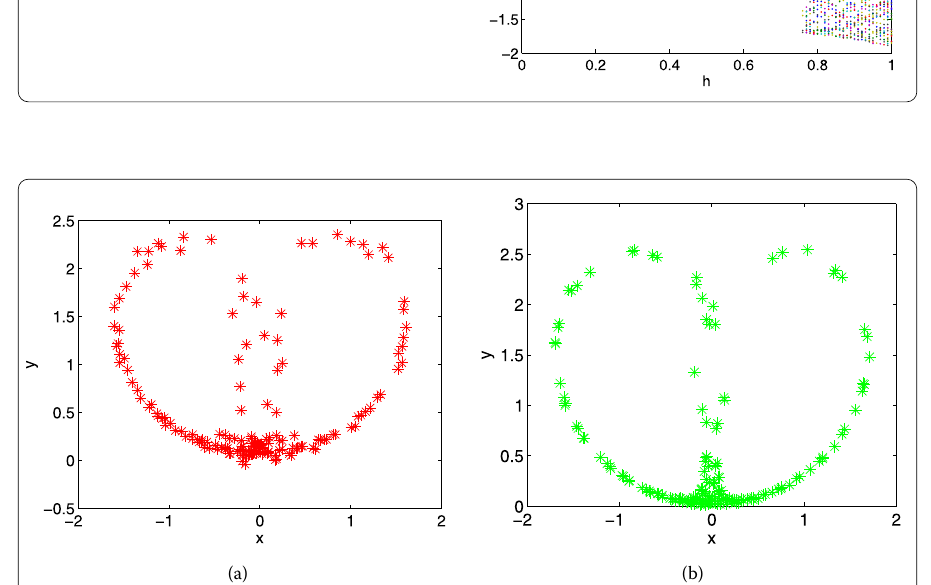
Figure 5 Phase portraits. The phase portraits of system (11) for α = 0.95, ( a ) a = 0.81, h = 0.95, ( b ) a = 1, h = 0.77